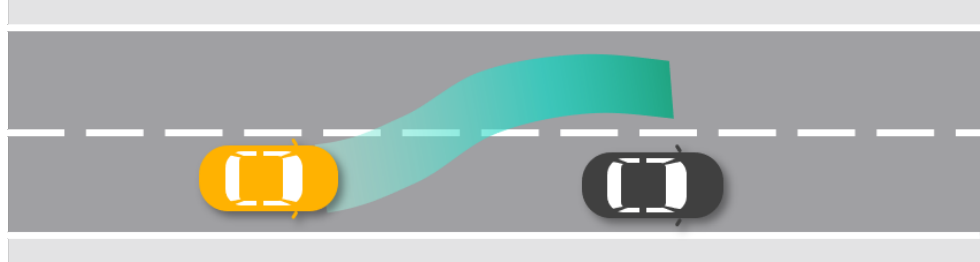
Figure 1. Overtake a stationary vehicle on